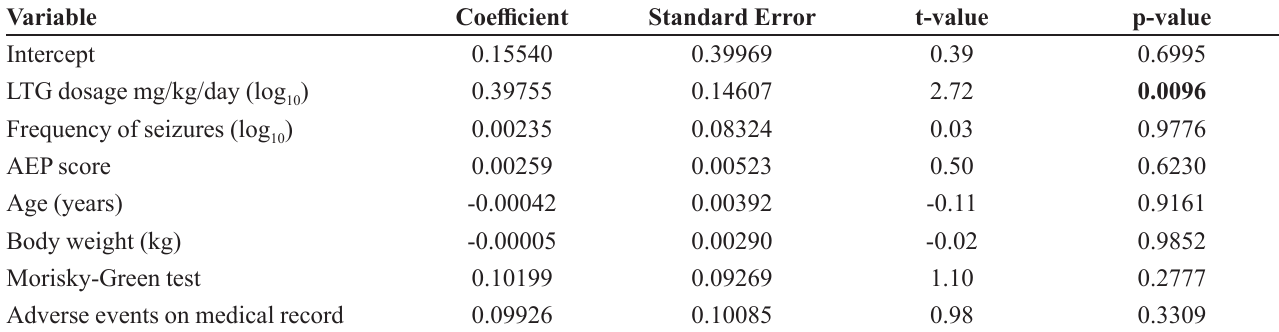
TABLE II - Multiple linear regression model of the lamotrigine plasma concentration with refractory epilepsy patients’ clinical and sociodemographic variables, treated at AEDC of HCFMRP-USP between May/2011 and April/2012 (n=75) R2=